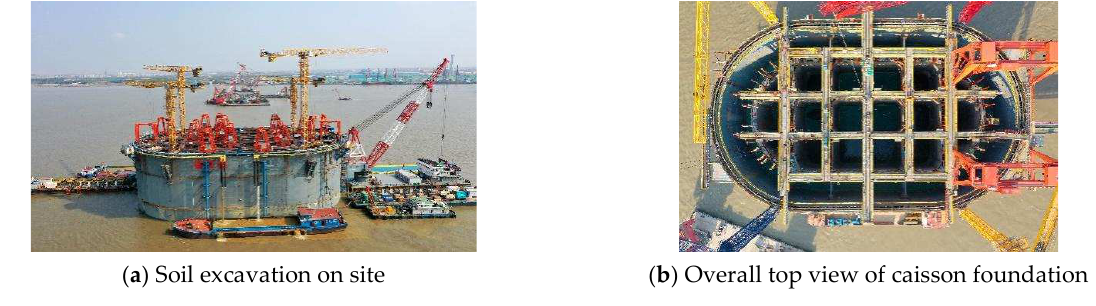
Figure 7. Overall soil excavation of caisson foundation.